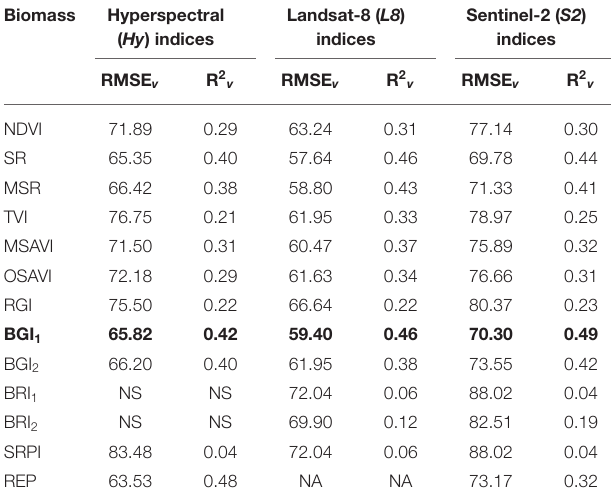
index with highest R 2 v